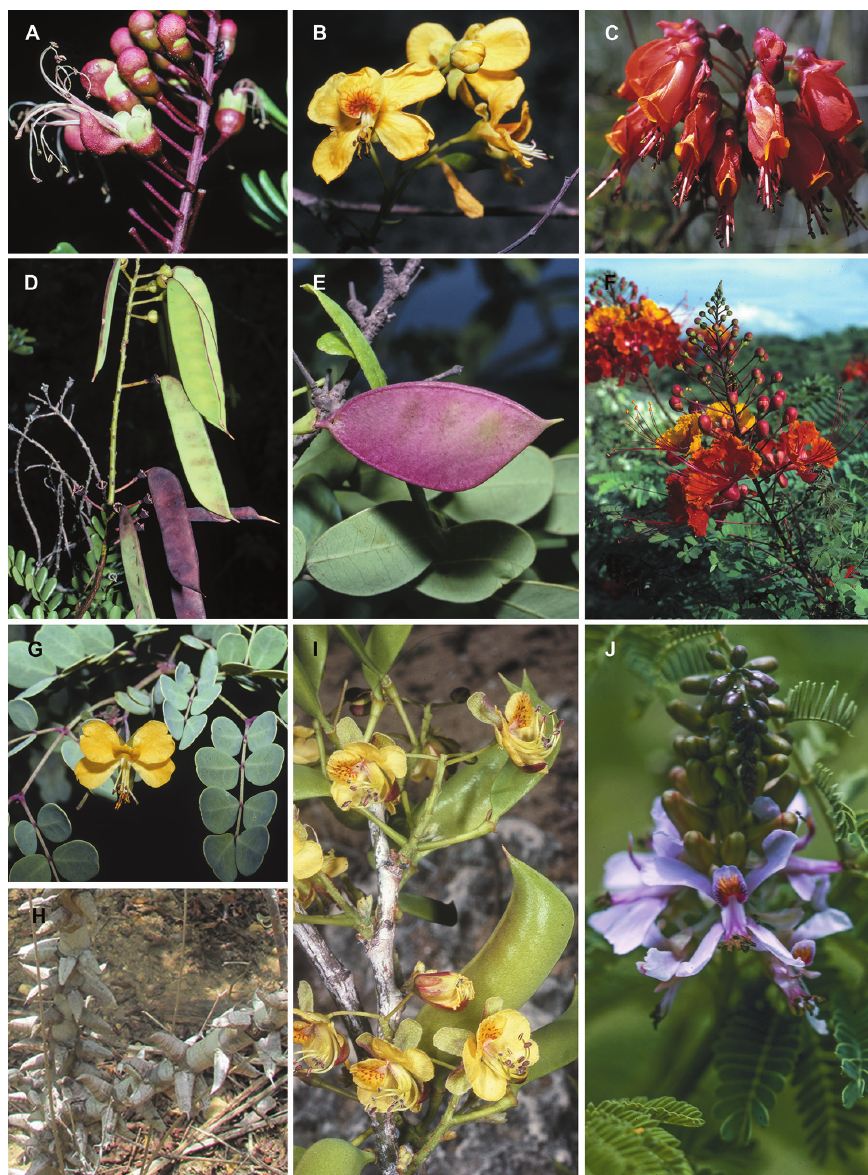
Figure 11. Caesalpinia bahamensis Lam. A inflorescence D fruits (G. P. Lewis, Cuba, Lewis 1853 (K)). Caesalpinia nipensis Urb. B flowers E fruits (G. P. Lewis, Cuba, Lewis 1838 (K)). Caesalpinia cassioides Willd. C inflorescence (C. E. Hughes, Ancash, Peru, Hughes et al. 2228 (K)). Caesalpinia pulcherrima L. (Sw.) F inflorescence (C. E. Hughes, Sonora, Mexico, unvouchered ); Denisophytum pauciflorum (Griseb.) E. Gagnon & G. P. Lewis G flower and leaves (G. P. Lewis, Cuba, Lewis 1854 (K)) H branch with spine- tipped woody protuberances (B. Torke, Cuba, Torke et al. 1424 (NY)). Denisophytum madagascariense R. Vig. I flowers and fruits (G. P. Lewis, Madagascar, Lewis et al. 2158 (K)). Gelrebia trothae (Harms) E. Gagnon & G. P. Lewis J inflorescence (P.J. Cribb, Tanzania, unvouchered